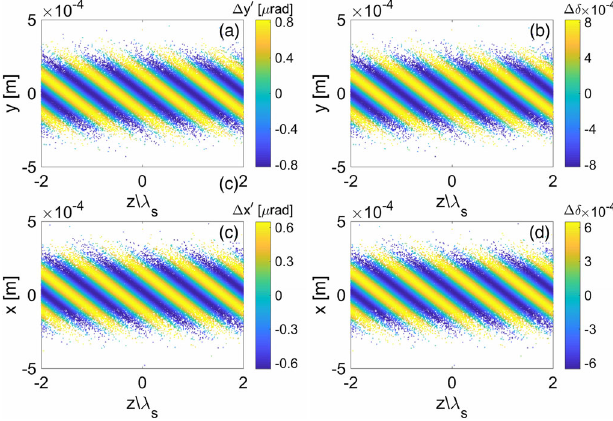
FIG. 3. Distributions of the induced divergences and energy deviations after the obliquely incident laser-electron interaction with a 3D simulation program. (a) and (b) refer to the laser incident in the z − y plane case; (c) and (d) refer to the laser incident in the z − x plane. For these two cases, the incident angles of the seed laser are both 1 mrad.